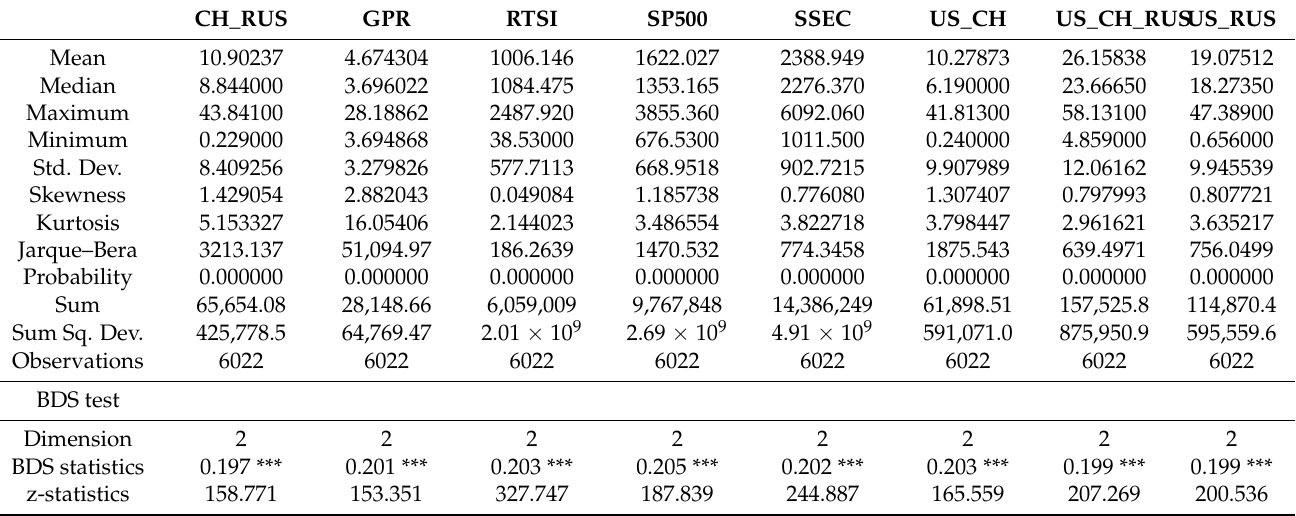
Table 2. Descriptive